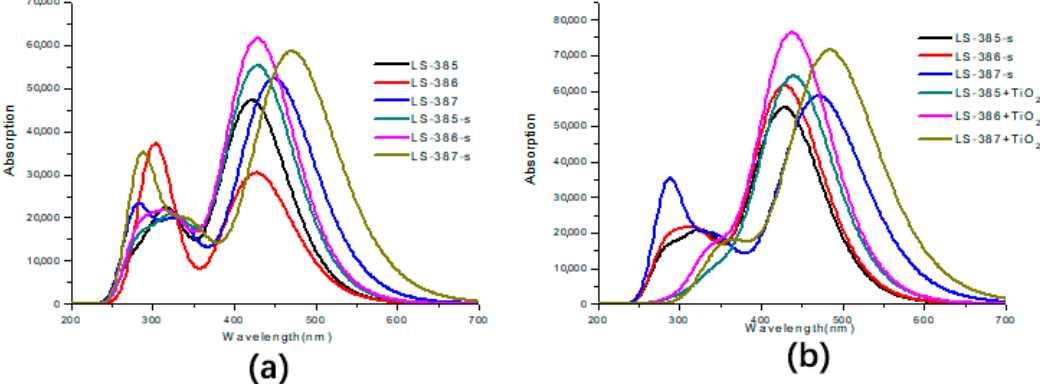
Figure 5. UV-Vis Absorption spectra of LS-385, LS-386, and LS-387 (where ( a ) represents in vacuum and ( b ) represents in DMF solvent).